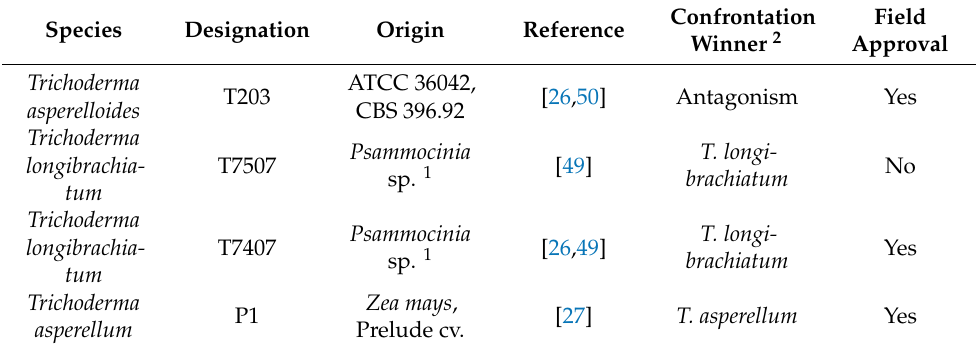
Table 1. Trichoderma species used in this